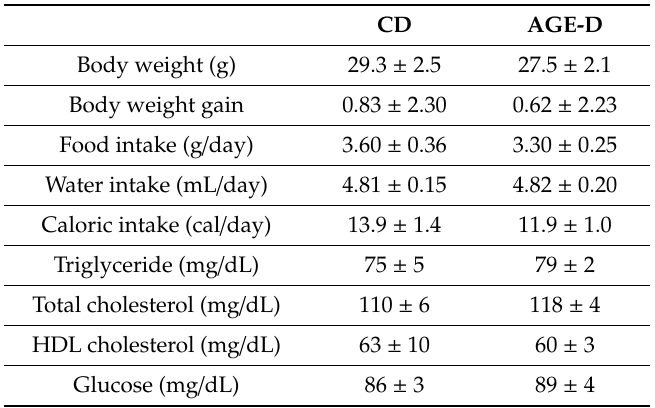
Figure 1. ( A ) Oral glucose tolerance test (OGTT) performed after 22 weeks of dietary manipulation on control not-irradiated standard diet (CD) and advanced glycation end products-enriched diet (AGE-D) mice. ( B ) Area under the curve showing altered OGTT in AGE-D mice indicating glucose intolerance. ( C – F ) Plasma levels of insulin, GLP-1, GIP, and ghrelin in CD and AGE-D mice measured by luminex suspension bead-based multiplexed Bio-Plex 3D system. Data are means ± S.E.M. ( n = 15 per group). Statistical significance: ** p < 0.01, * p < 0.05 vs. CD. Table 1. E ff ects on mice body weight and systemic lipid / glucose profile at 22 weeks of the AGE-enriched diet (AGE-D) in comparison to the control diet (CD).